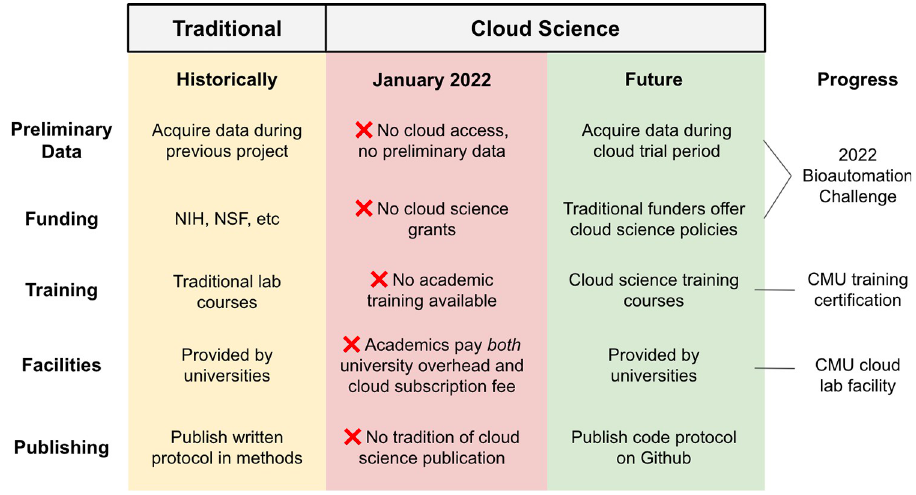
Fig 1. Life cycle of barriers to academic use of cloud labs. Academic scientists face barriers to adopting cloud science at every stage of a normal project’s life cycle. New programs can encourage changes to the ecosystem that make cloud science more accessible to researchers in the long